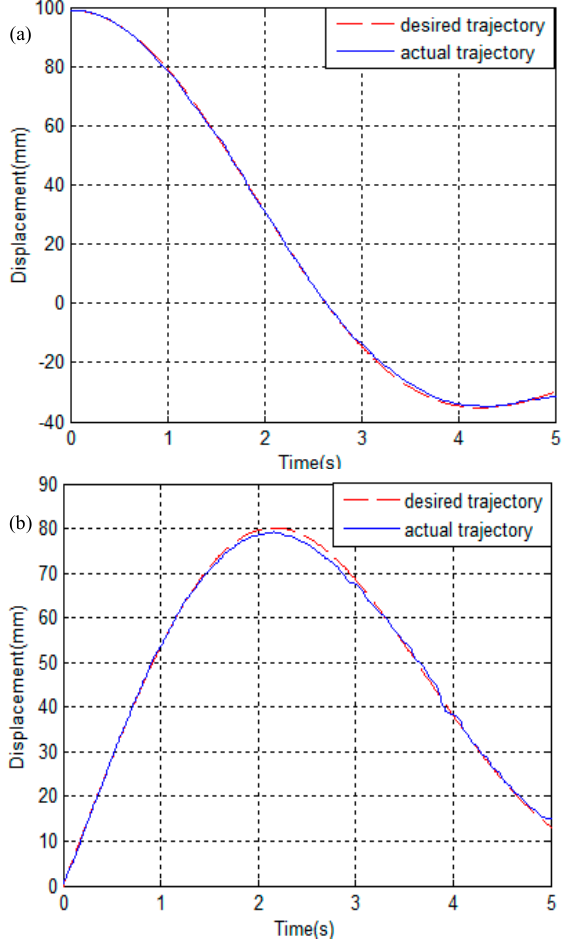
Figure 9. Passive rehabilitation experiment: ( a ) x t direction displacement; ( b ) y t direction displacement.